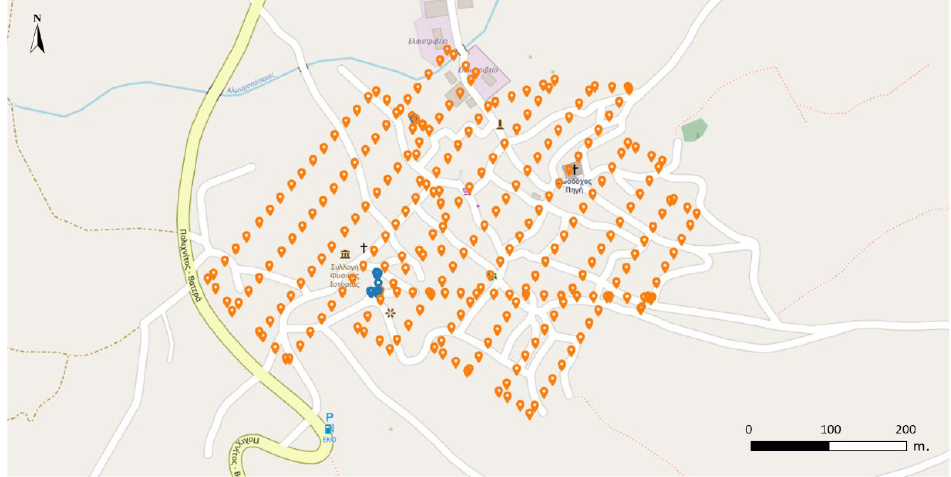
Figure 8. Visualization of trajectory of flight over the village of Vrissa. Blue-colored points represent